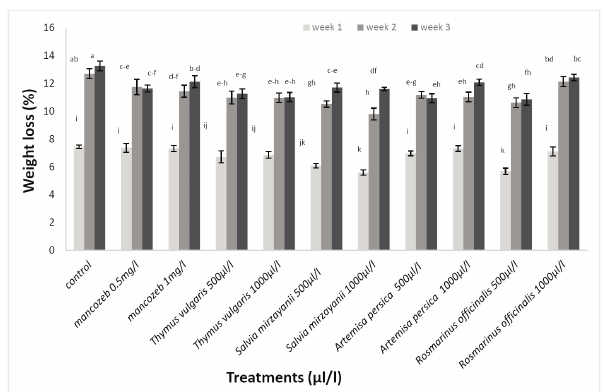
Fig. 3 - Effect of the Thymus vulgaris , Salvia mirzayanii , Artemisia persica and Rosmarinus officinalis EOs tested at 500 and 1000 μl/l on mangos weight loss after 1, 2, and 3 weeks of storage compared to ‘mancozed’ (0.5 and 1.0 mg/l). Bars indicate the SD of the mean. Different let- ters indicate significant differences in mean values (p <0.05). Fig. 4 - Effect of the Thymus vulgaris , Salvia mirzayanii ,